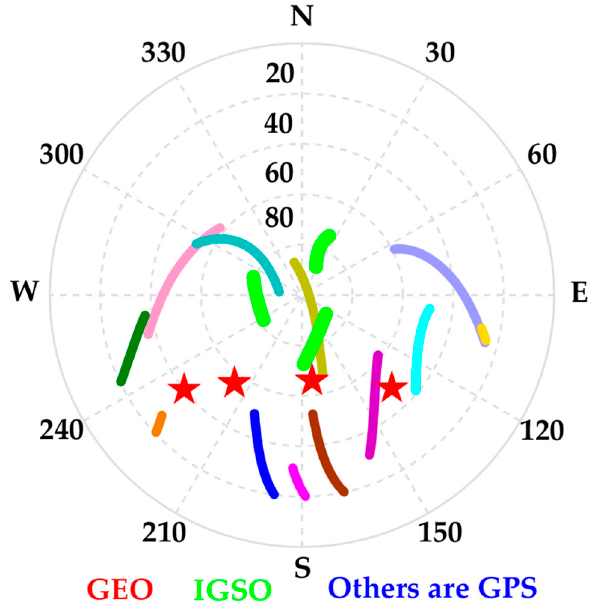
Figure 8. Azimuth-elevation based sky plot of the observed GEO, IGSO, and GEO satellite.